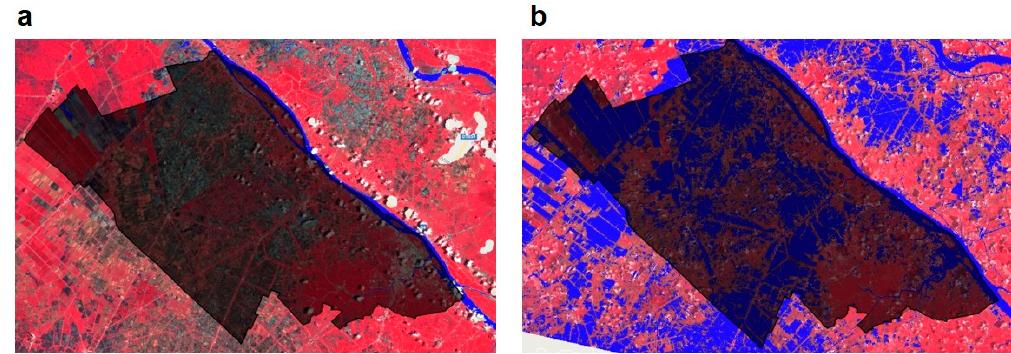
Figure 7. False color Sentinel-2 image showing the study area during ( a ) dry season and ( b ) flood season.